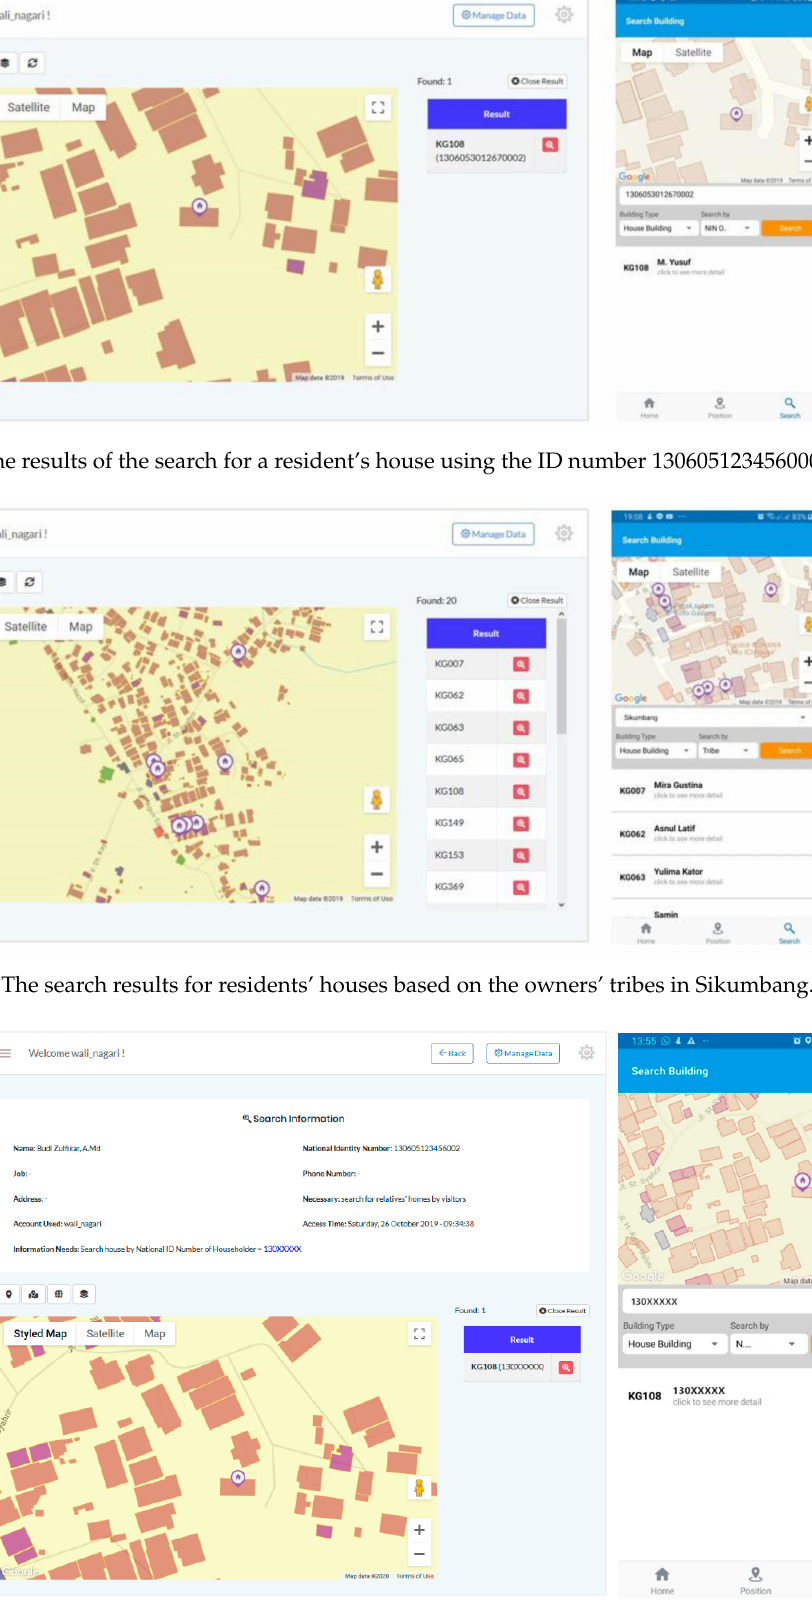
Figure 15. The search service used to find a resident’s house.